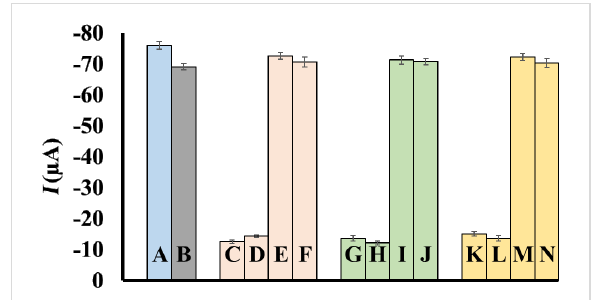
Figure 5: Differences in signal intensities in presence of interference miR-15a (nc1), miR-21 (nc2), and miR-200c (nc3). (A) miR-106a (10 pM); (B) miR-106a (10 pM) + nc1 (10 pM) + nc2 (10 pM) + nc3 (10 pM); (C) nc1 (10 pM); (D) nc1 (50 pM); (E) miR-106a (10 pM) + nc1 (10 pM); (F) miR-106a (10 pM) + nc1 (50 pM); (G) nc2 (10 pM); (H) nc2 (50 pM); (I) miR-106a (10 pM) + nc2 (10 pM); (J) miR-106a (10 pM) + nc2 (50 pM); (K) nc3 (10 pM); (L) nc3 (50 pM); (M) miR- 106a (10 pM) + nc3 (10 pM); (N) miR-106a (10 pM) + nc3 (50